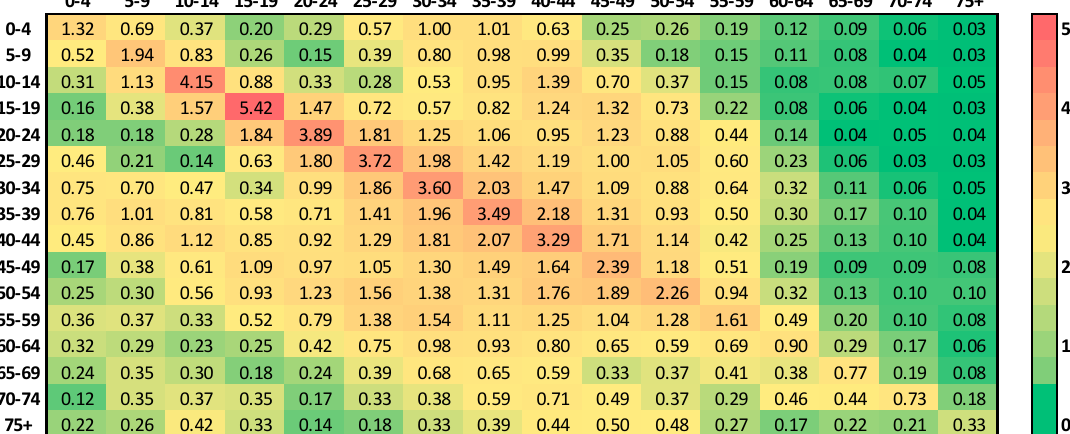
Table 3. Overview of the constants and contact matrixes used for each policy.